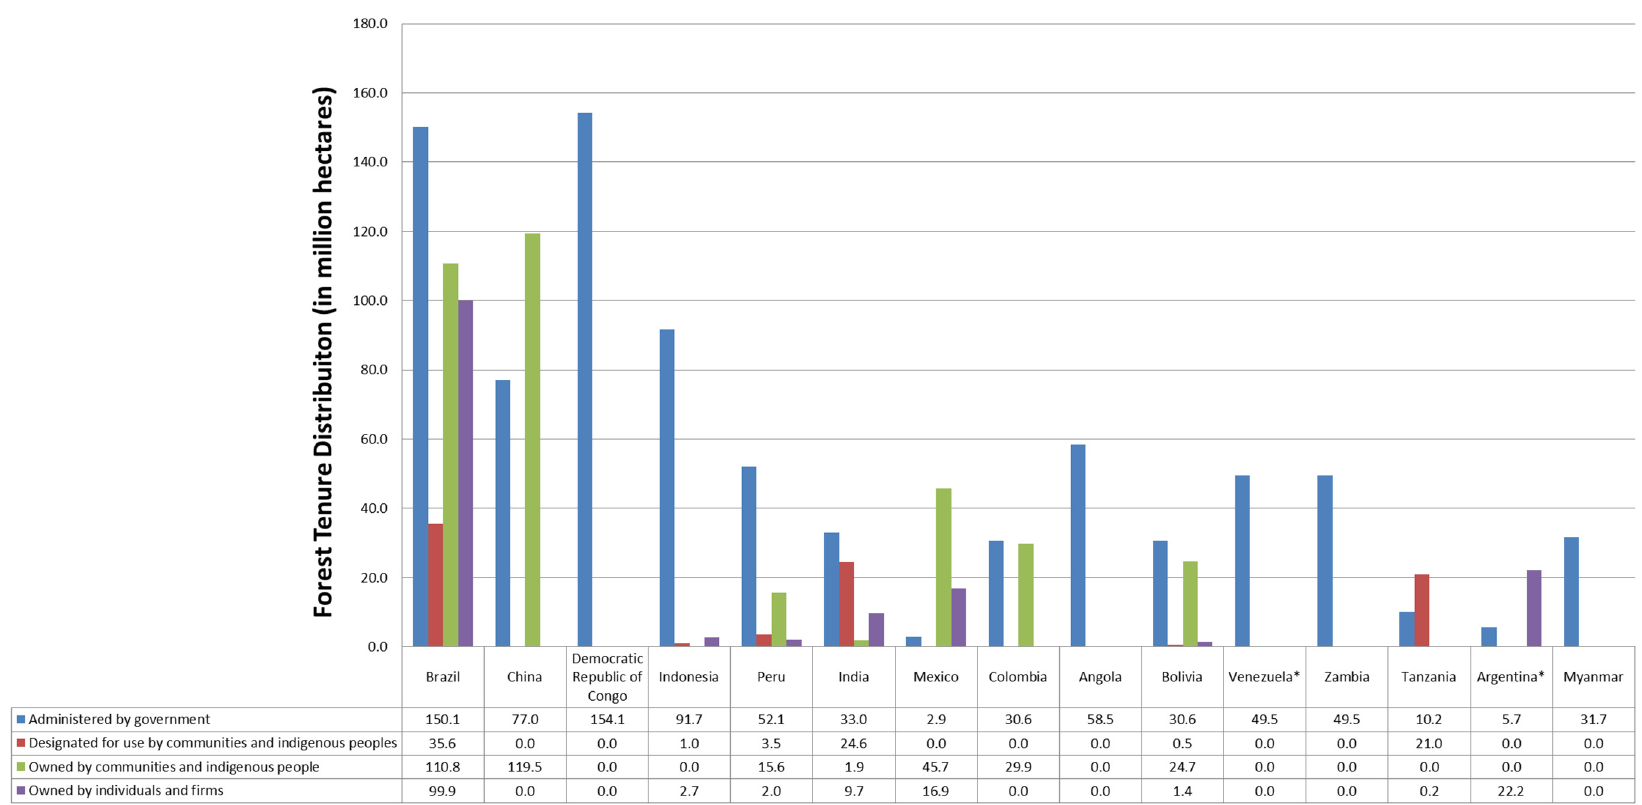
Figure 2. Forest tenure distribution for the 15 most forested developing countries (millions of hectares) in 2013. Source: RRI’s Forest tenure tool [35]; * No data were available for the year 2013.